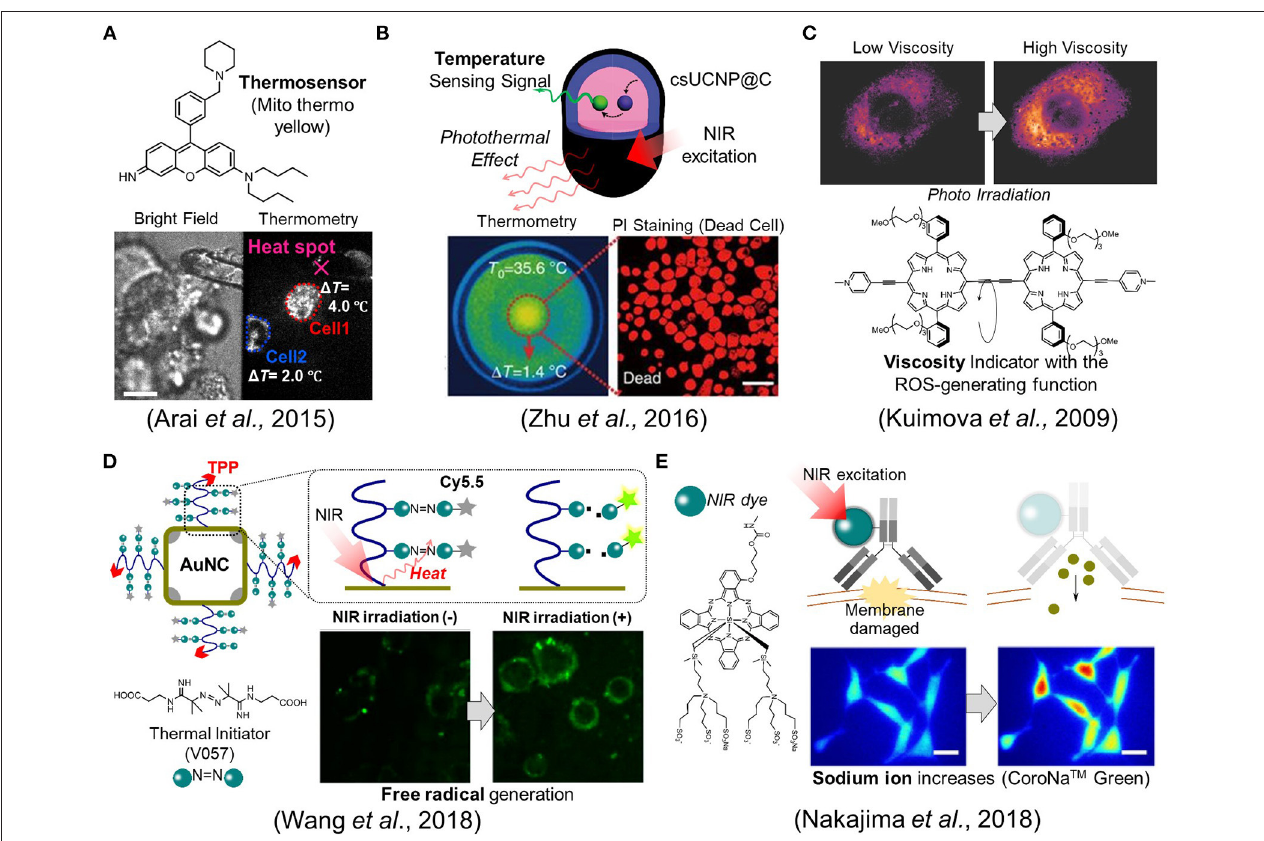
FIGURE 2 | Fluorescence imaging studies in biomaterials development. (A) A mitochondrial targeting temperature indicator (Mito thermo yellow) detected the different temperature increment of each cell within a bunch of HeLa cells. Scale bar, 10 µ m. (B) The nanocomposite, csUCNP@C, which comprises a phothermal heater and a thermometer, allows the induction of cell death while concurrently measures the temperature. Scale bar, 50 µ m. (C) The porphyrin-dimer functions as a photosensitizer and an intracellular viscosity indicator. (D) The gold nanocage (AuNC) which acts as an efficient photothermal material was decorated with the thermal initiator (V057) and a fluorescent dye (Cy5.5). The free radical species was generated following the cleavage of V057 by photothermal effect. The free radical generation could be monitored with the fluorescence intensity change of Cy5.5. (E) The ion indicator, CoroNa TM Green, detected the sodium ion influx during photoimmunotherapy. Scale bar, 20 µ m. Reproduced with permission from (A) ( Arai et al., 2015); copyright Royal Society of Chemistry, (B) (Zhu et al., 2016); copyright Nature Publishing Group, (C) (Kuimova et al., 2009); copyright Nature Publishing Group, (D) (Wang et al., 2018); copyright American Chemical Society, and (E) (Nakajima et al., 2018); copyright John Wiley &